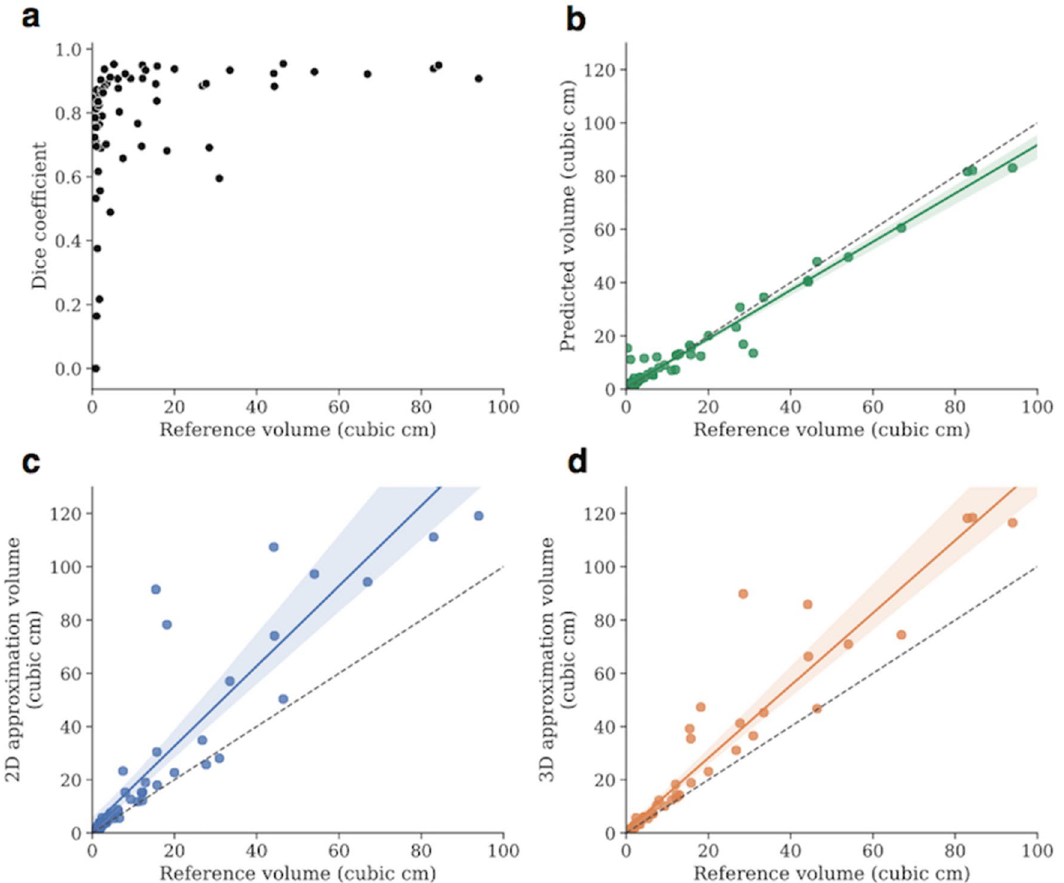
Figure 2. Algorithm’s tumor segmentation and volume estimation accuracy. ( a ) Scatter plot showing the algorithm’s segmentation performance expressed as Dice scores on the test set as a function of the tumor volume. The Dice score correlated with the size of the tumor, quickly reaching a mean of 0.87 and median of 0.89 for tumors > 2 cc. ( b – d ) Volume estimations by the algorithm, and the 2-D and 3-D traditional estimation techniques, respectively. The algorithm’s predicted volumes constitute almost perfect approximations of the real tumor volumes with a correlation of 0.98, p < 0.001 ( b ), whereas the 2D and 3D techniques present lower values of respectively 0.88 ( c ) and 0.96 ( d ) p < 0.001, with evidence of overestimation. Mean (s) SD (s) Time reduction (%) p